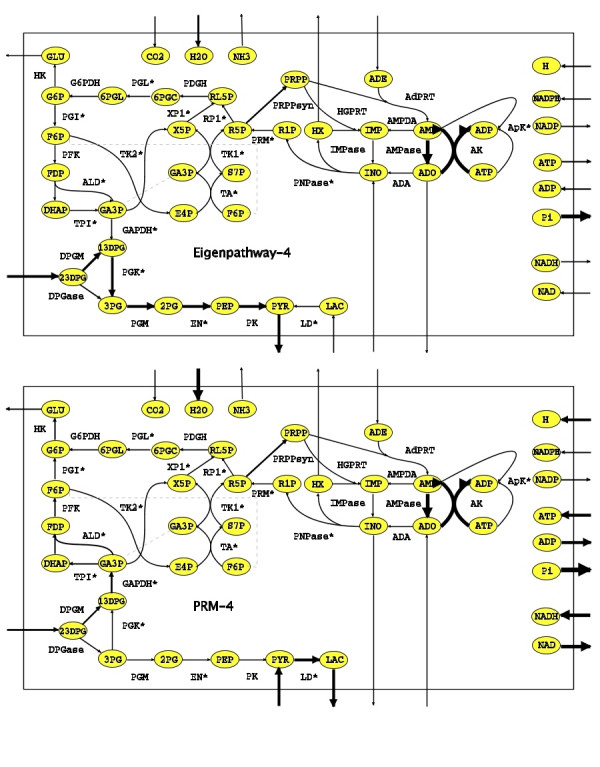
The fourth eigenpathway derived from SVD of the extreme pathways matrix and the fourth PRM derived from SVD of the samples matrix for the hRBC metabolic network. The relative values of the flux values is indicated by the thickness of the arrows between metabolites. The metabolite and reaction definitions are given in Table 1 and Table 2.